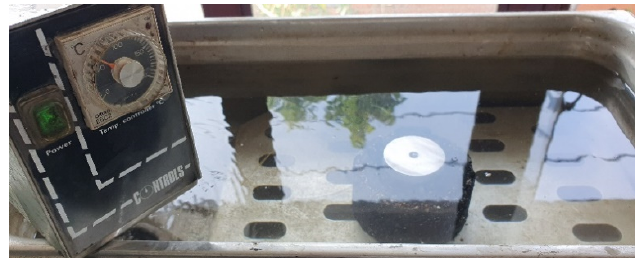
Figure 5. A water bath to control the pull-off tensile strength test sample.